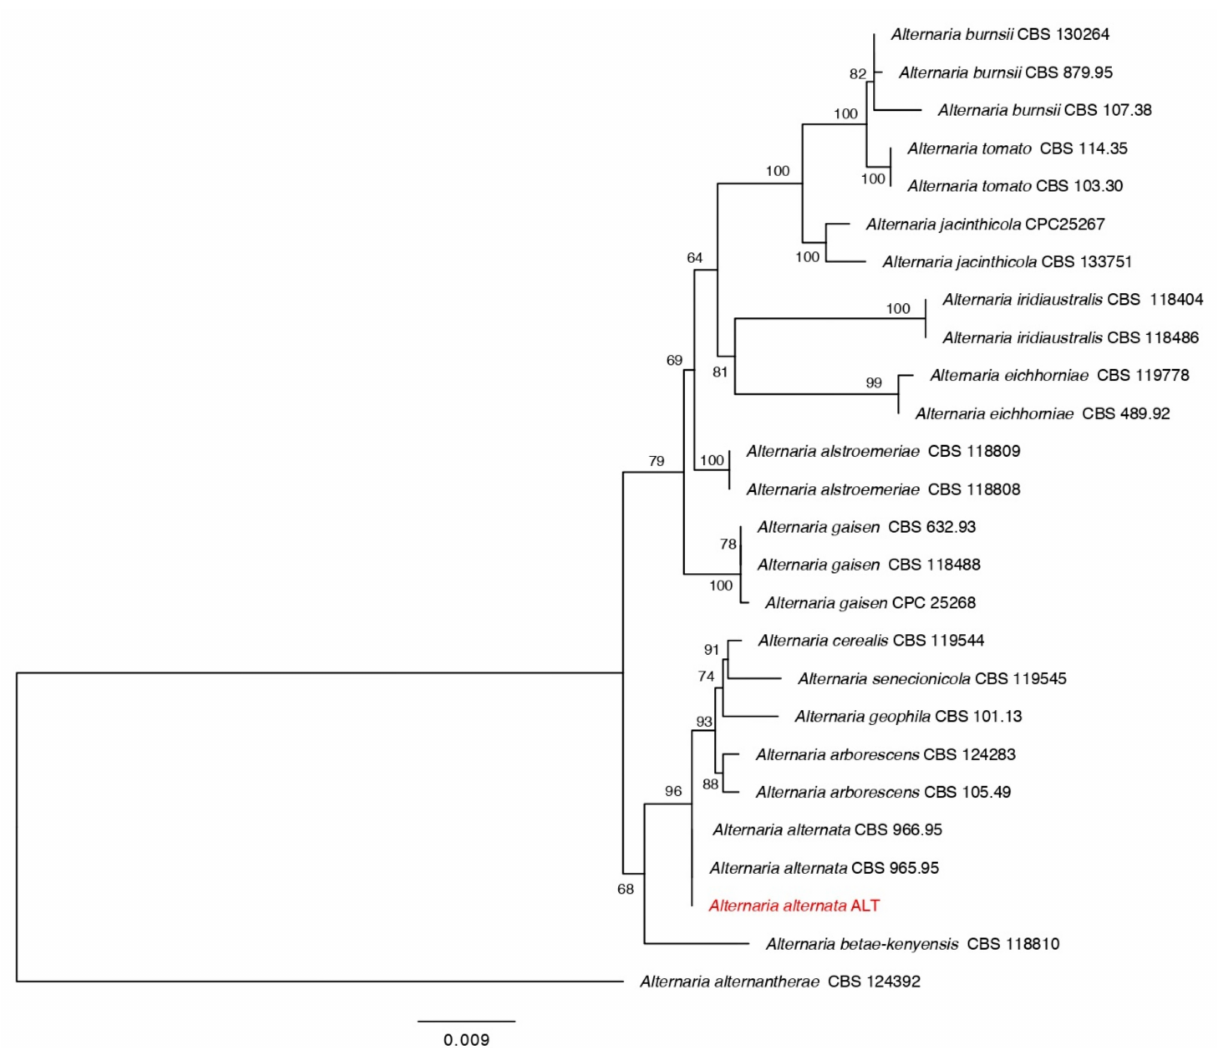
Figure 1. Maximum likelihood tree obtained from the combined ITS, GAPDH, and Alt a 1 sequence alignment analysis of the species in section Alternaria . Bootstrap values (>50) are represented by numbers at the nodes based on 1000 replications. The strain in red font is from our